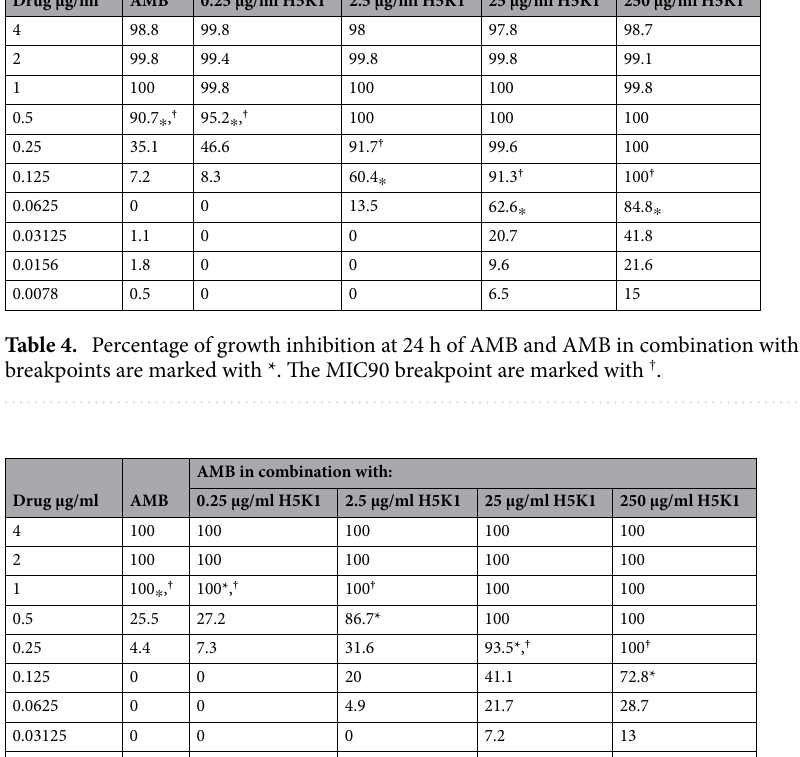
Table 5. Percentage of growth inhibition at 48 h of AMB and AMB in combination with H5K1. The MIC50 breakpoints are marked with *. The MIC90 breakpoint are marked with † .